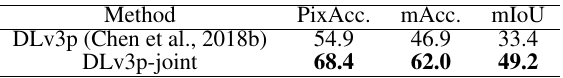
Table 3. Evaluation of LISU. We copy the results of the baseline model LISU-seg from Table 1 for clear comparison.